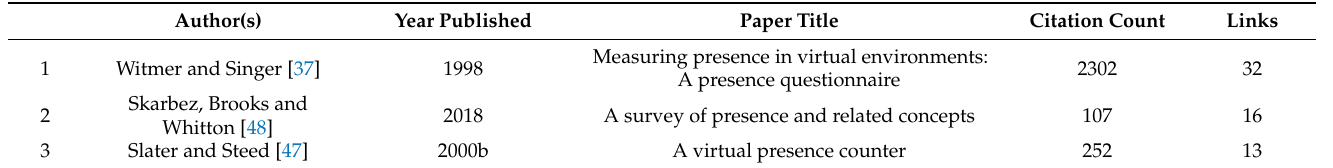
Table 8. Top three most influential publications with the strongest relationship resulting from citation analysis.